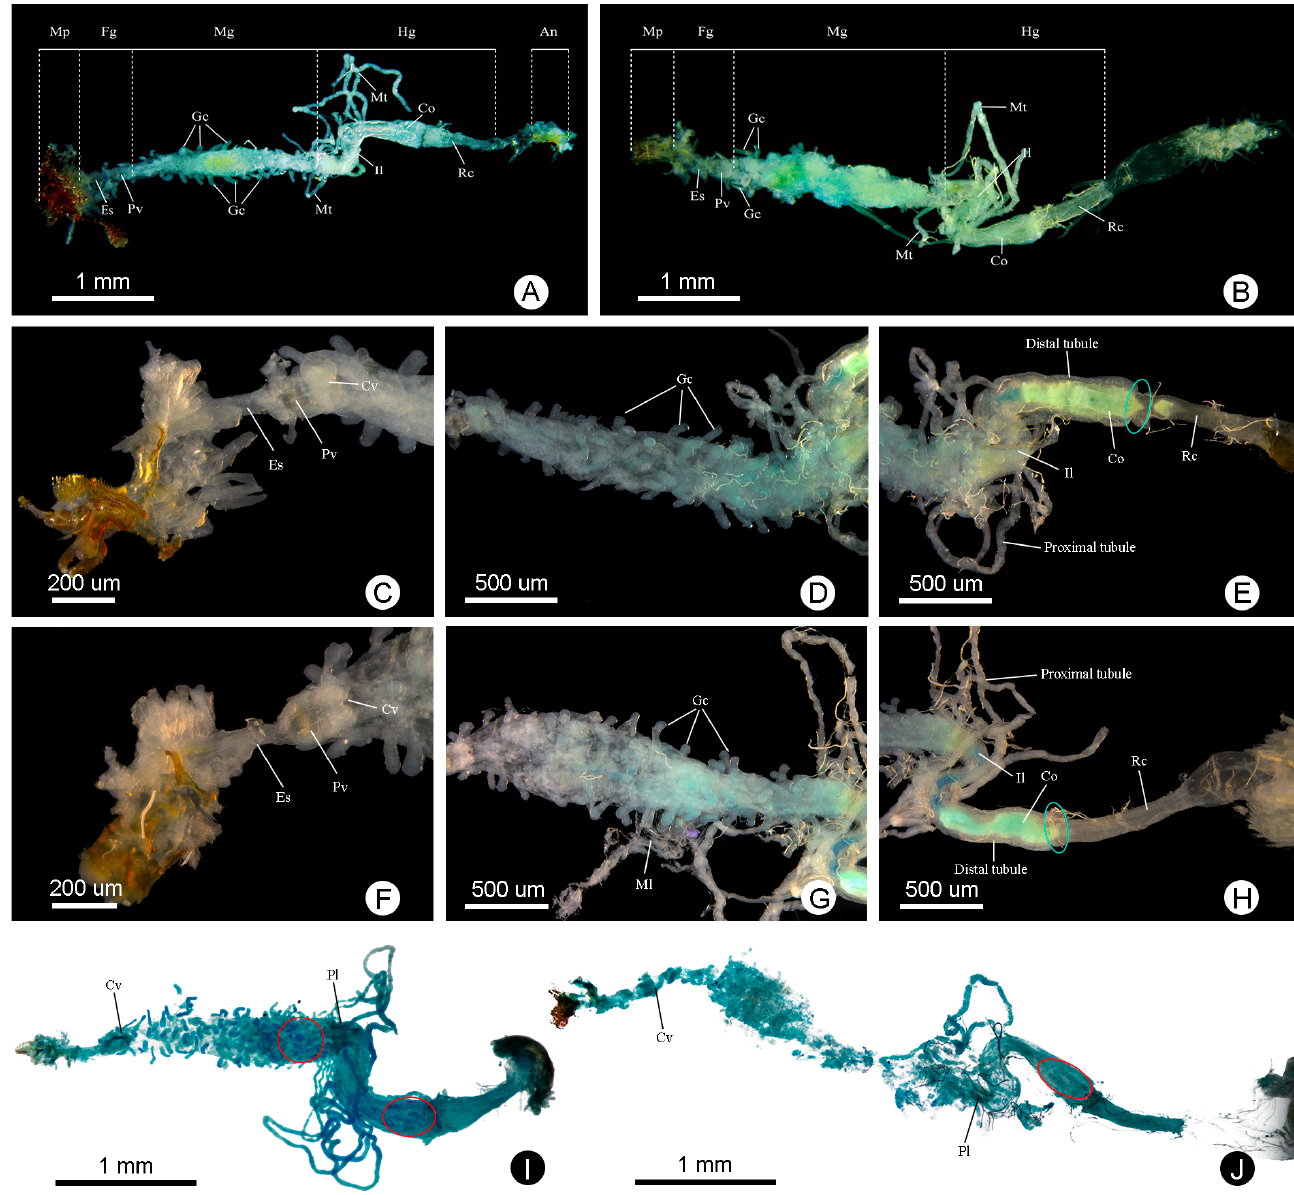
Figure 3. Structural and schematic pictures of the alimentary canal and Malpighian tubules of male and female of M . ( O .) chinensis : ( A ) male alimentary canal and Malpighian tubules (LM); ( B ) female alimentary canal and Malpighian tubules (LM); ( C ) male foregut (LM); ( D ) male midgut (LM); ( E ) male hindgut (LM); ( F ) female foregut (LM); ( G ) female midgut (LM); ( H ) female hindgut (LM); ( I ) male alimentary canal and Malpighian tubules (FM); ( J ) female alimentary canal and Malpighian tubules (FM). Green circles in ( E , H ) show the short membranous structure. Red circles in ( I , J ) show digested pollen grains. LM: light microscopy, FM: fluorescence microscopy, An: anus, Co: colon, Cv: cardiac valve, Es: esophagus, Fg: foregut, Gc: gastric cecum, Hg: hindgut, Il: ileum, Mg: midgut, Ml: muscle layer, Mp: mouthpart, Pl: pylorus region, Pv: proventriculus, Rc: rectum, Mt: Malpighian tubule.